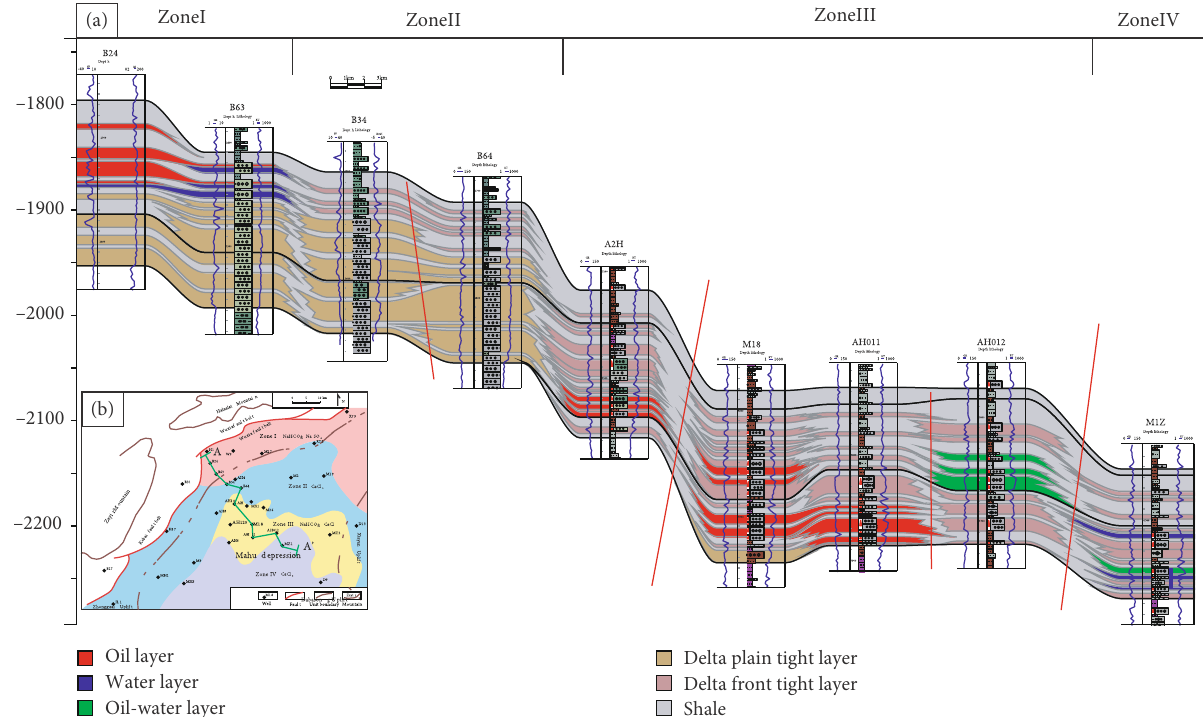
Figure 4: (a) Reservoir pro fi le map for the Baikouquan Formation. (b) Location of the reservoir pro fi le map in the study area (A-A ’